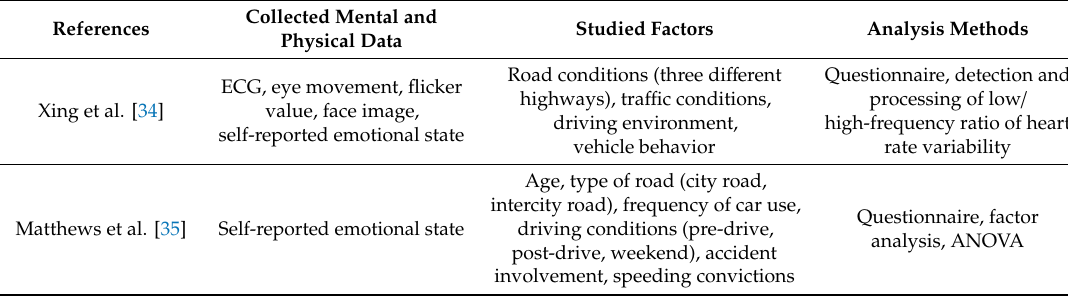
Table 2. Previous studies on driving stress.